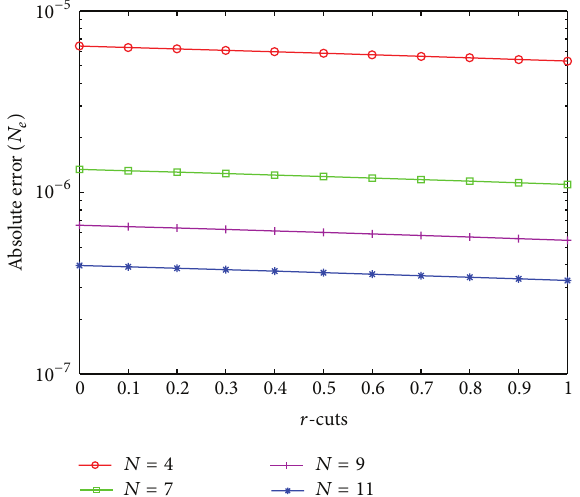
Figure 3: The absolute errors for different values 𝑁 with V = 0.95 , 𝑘 1 = 0.11 and 𝛼 = 𝛽 = 0 , Case